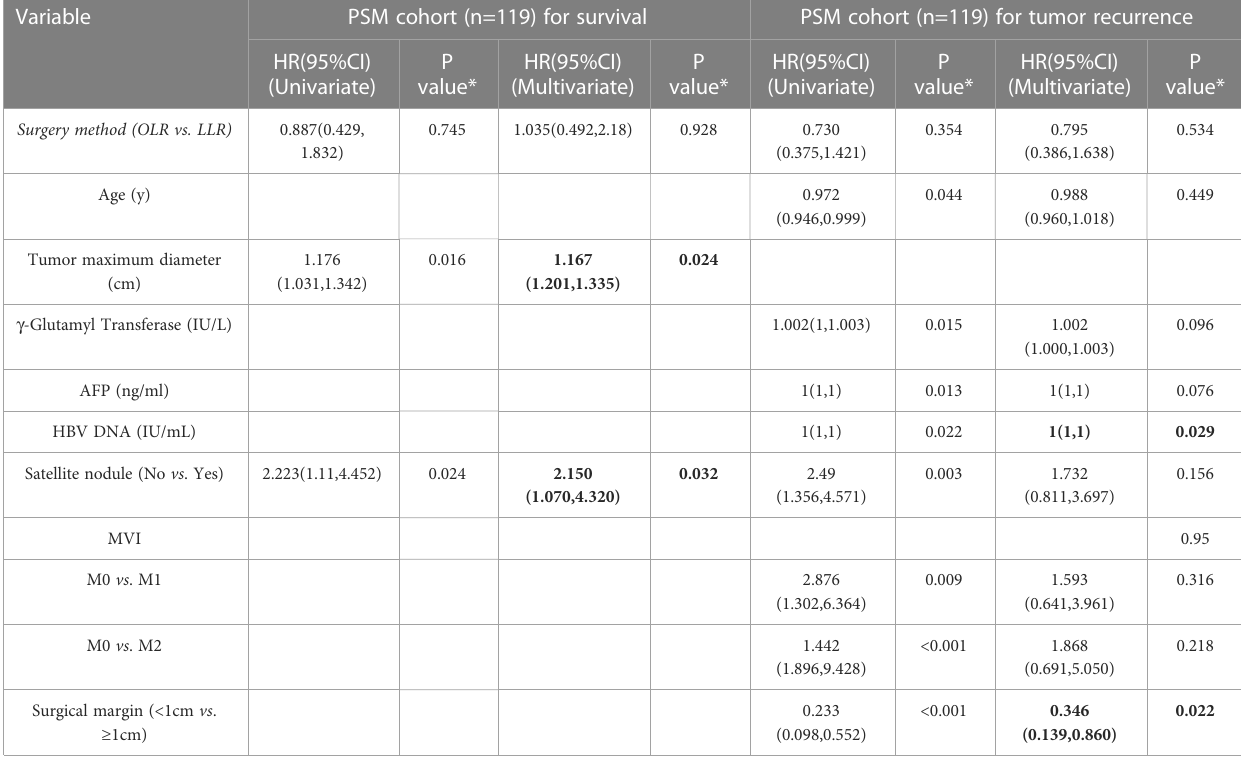
TABLE 3 Univariate and multivariate analysis of relative risk factors for PSM